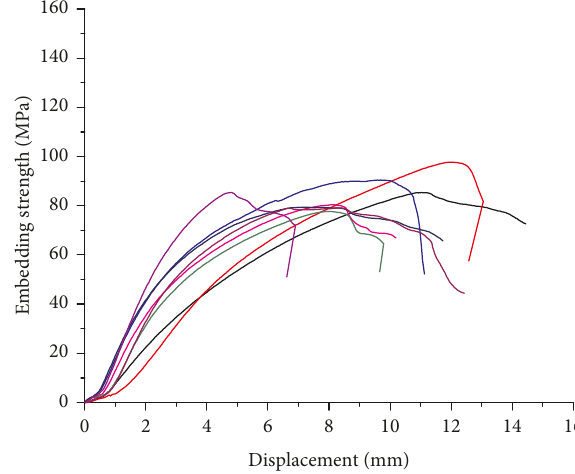
Figure 9: Strength-displacement curve of group H3.